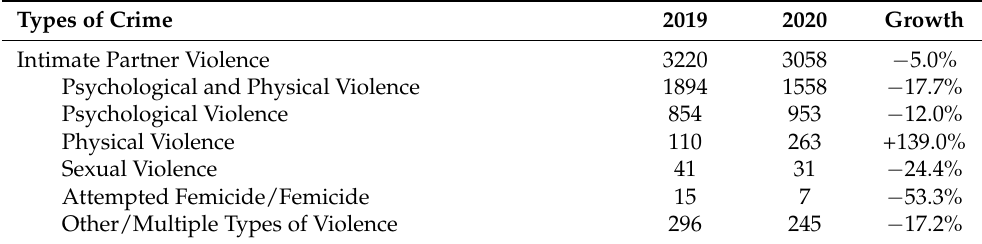
Table 2. IPV crimes reported in requests for help during 2019 and 2020.